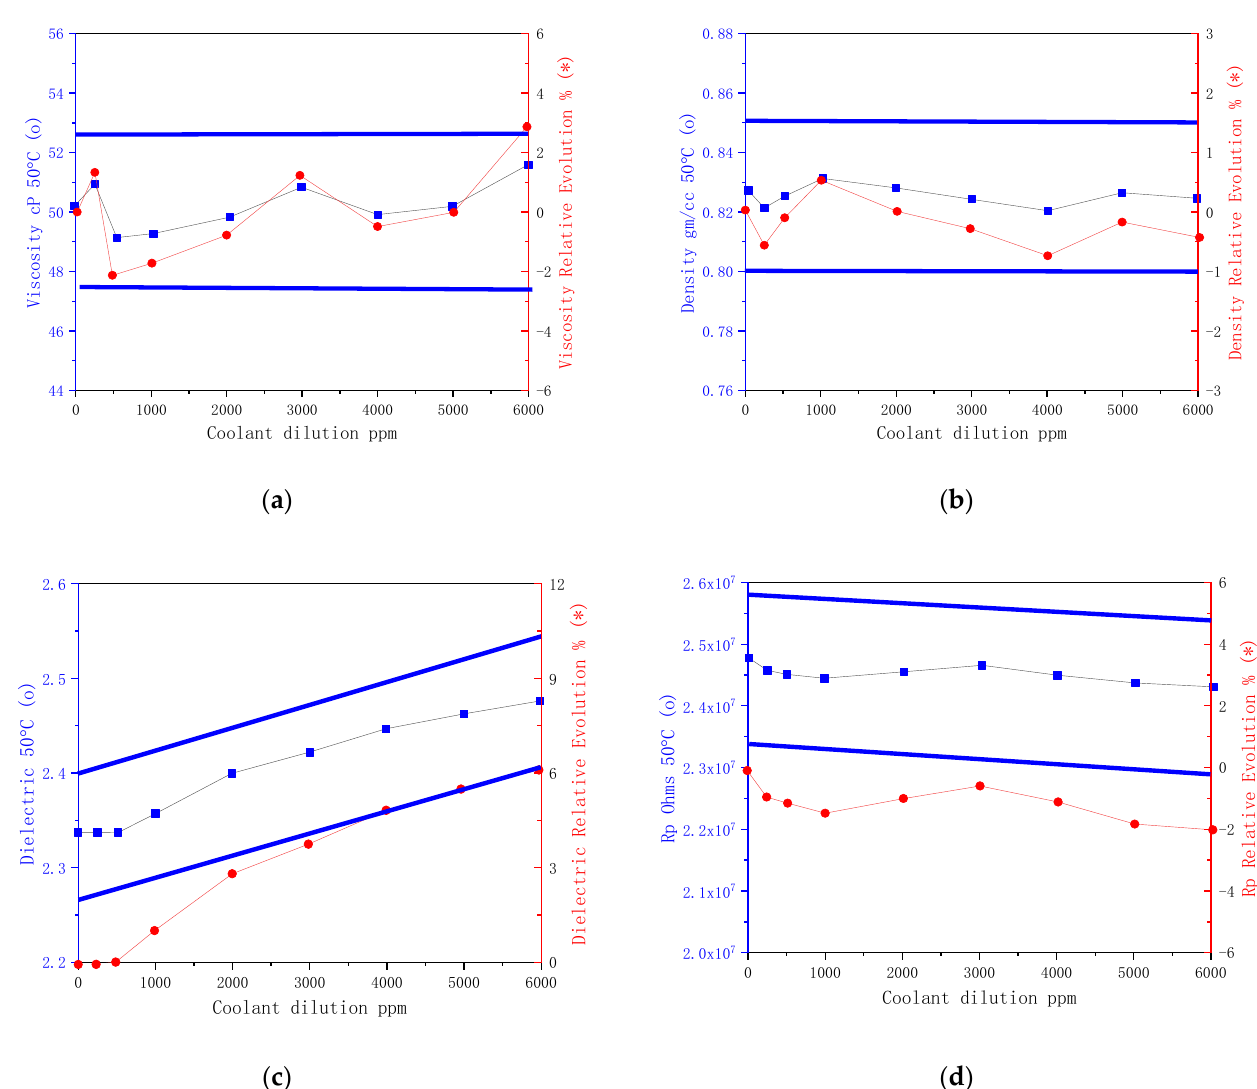
Figure 13. Coolant dilution in engine oil (15W40) at 50 °C: ( a ) viscosity; ( b ) density; ( c ) dielectric; and ( d ) Rp.